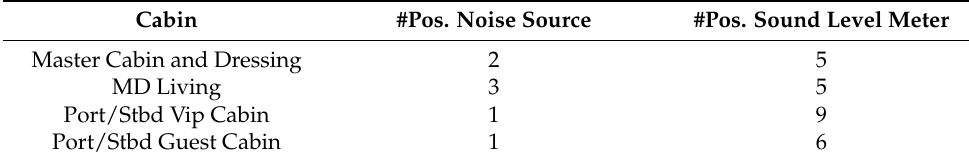
Table 2. Number of measurements of the reverberation